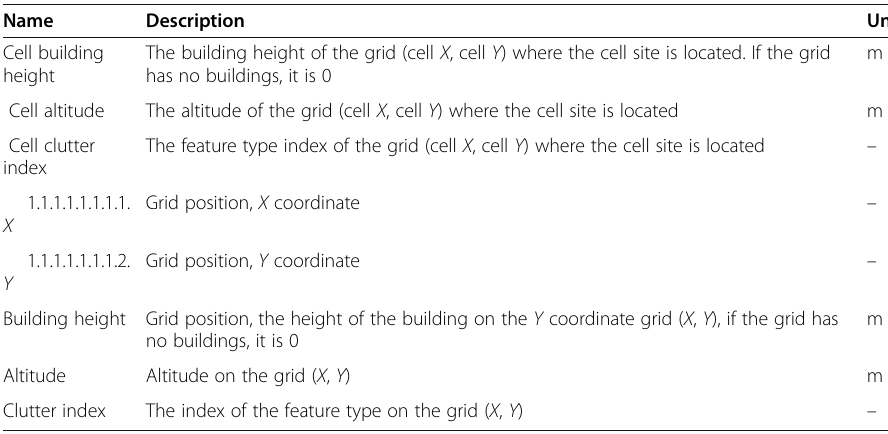
Table 2 Description of geographic information data Name Description